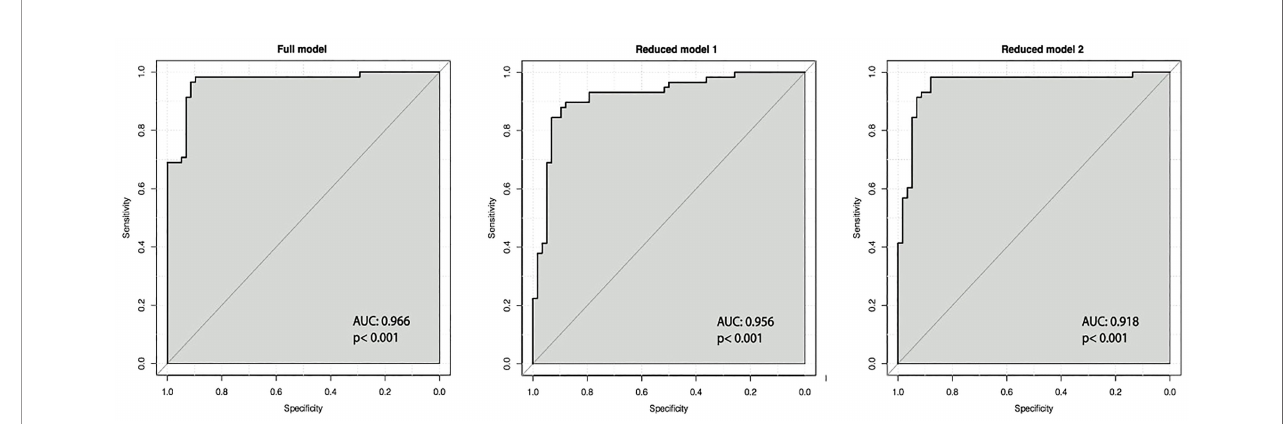
FIGURE 1 | ROC curves for linear discriminant models. For each parameter, the area under the curve (AUC) and the p-value are